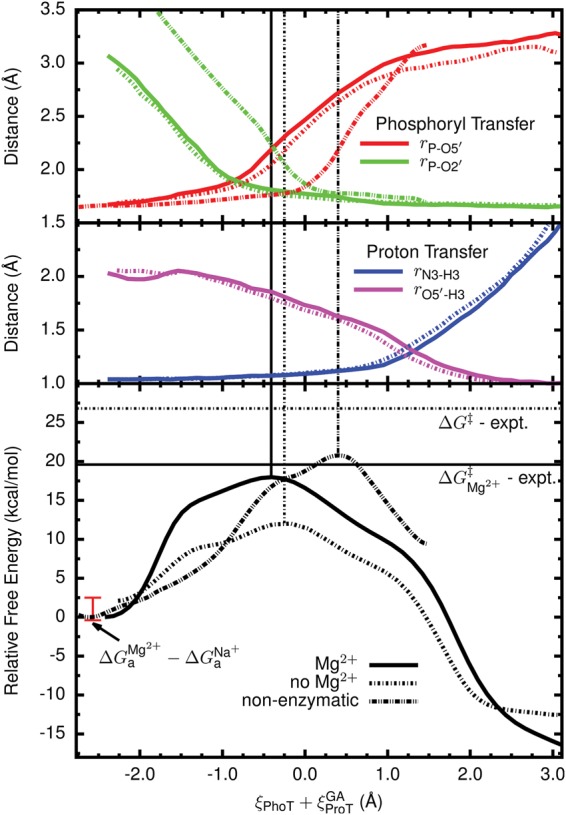
Reaction profiles (bottom) along the minimum free energy paths for the HDVr catalytic reaction starting from an activated (i.e., deprotonated) state with and without the presence of Mg2+ at the position hypothesized by Chen et al. (2010) (solid and dashed lines, respectively). The zeros of energy are set according to an estimated relative free energy of deprotonation (ΔGaMg2+−ΔGaNa+=−2.1kcal/mol). Averages of selected bond lengths along the path are also shown (top). The calculated (including correction) and experimental barrier heights (from classical transition state theory, in kcal/mol) are 18.0 and 19.6 (Chen et al. 2013) and 12.1 and 26.8 (Thaplyal et al. 2013) for the reactions with and without Mg2+, respectively.